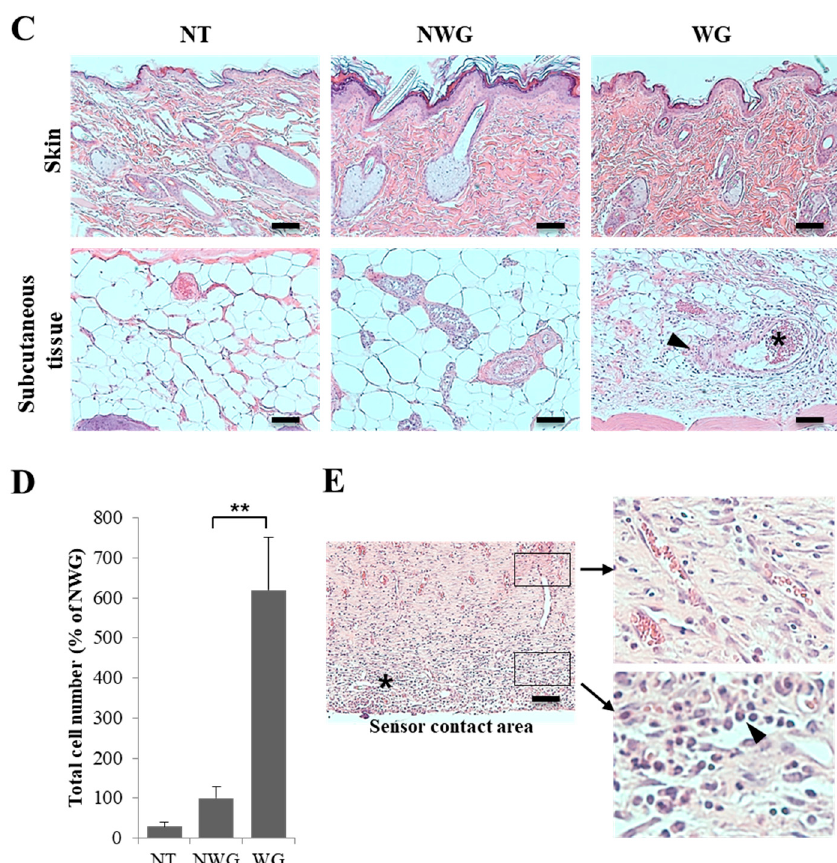
Figure 2. ( A ) Angiogenesis was induced in the skin by a functioning ECG sensor (NT, normal; NWG, not working group; WG, working group); ( B ) Sensor status of subcutaneous tissue according to wireless-powered transmission and sensor operation; ( C ) Hematoxylin and eosin staining of the skin and subcutaneous tissues showed that the sensor induced infiltration of inflammatory cells into the subcutaneous tissue. A number of inflammatory cells were observed in blood vessels (asterisk) and the surrounding tissues (arrowhead) (NT, normal; NWG, not working group; WG, working group); ( D ) Cell infiltration was increased by wireless-powered transmission; ( E ) There were numerous inflammatory cells in the contact area of the sensor (asterisk), and blood vessels were formed on the back side of sensor. Right insets show enlarged images of surrounding tissues (asterisk, inflammatory cells; arrowhead, eosinophil; scale bar, 100 μ m). Significant difference from NWG, ** p < 0.01.